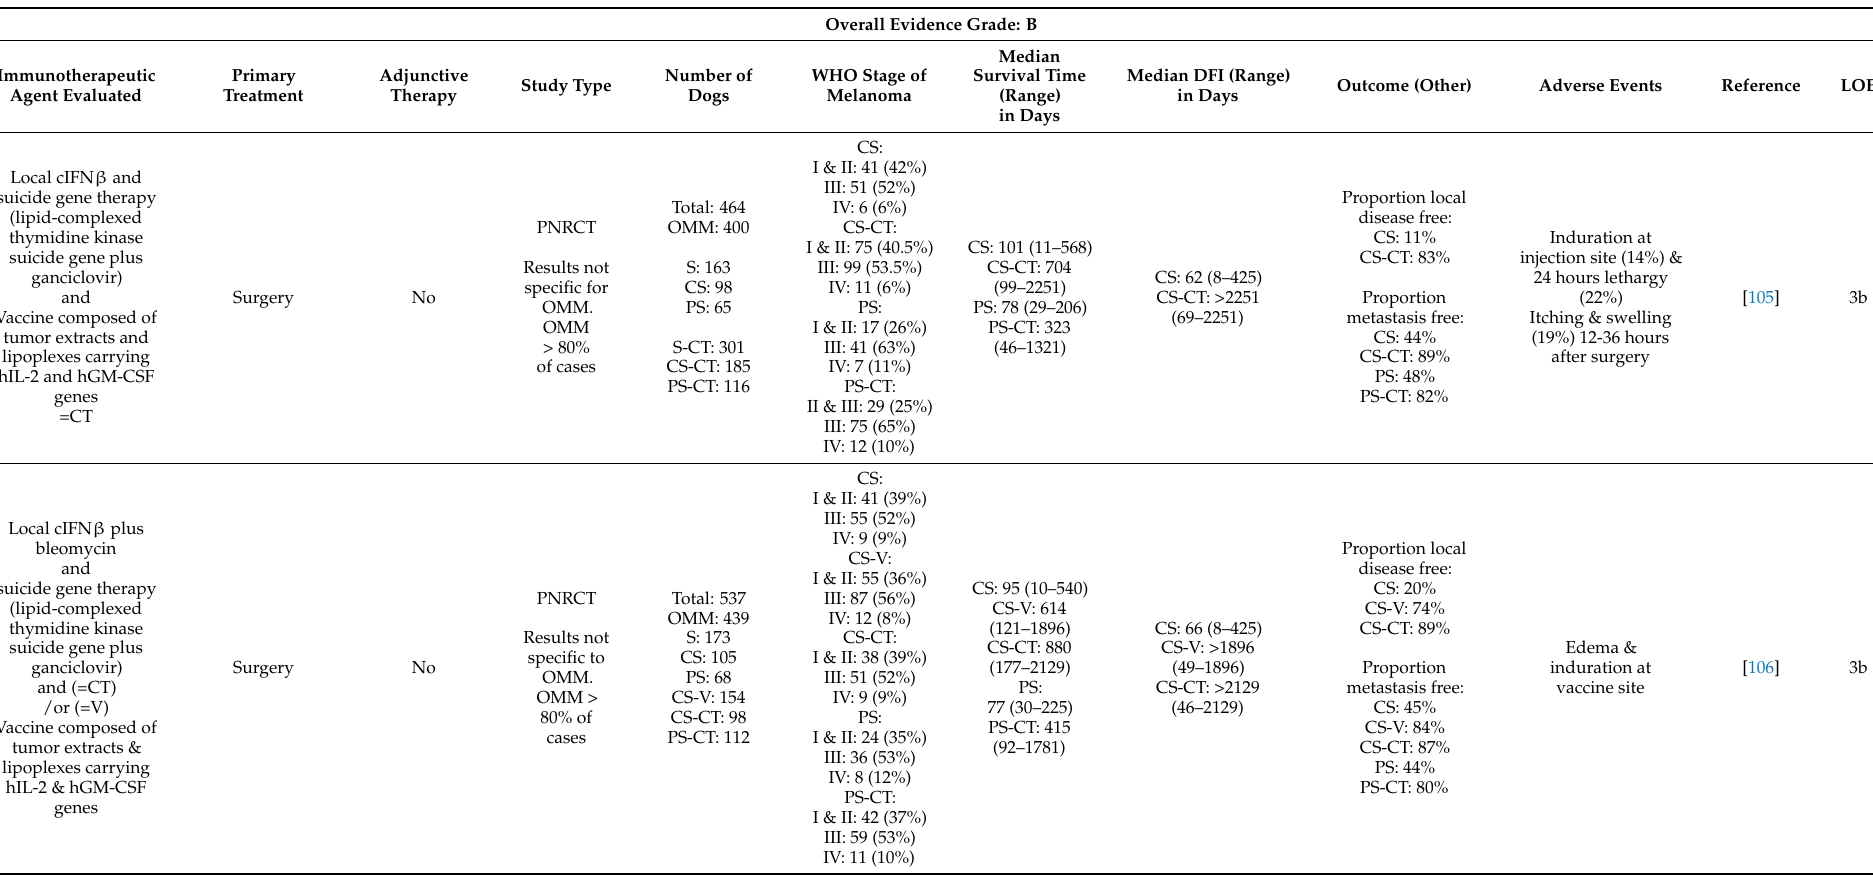
Overall Evidence Grade: